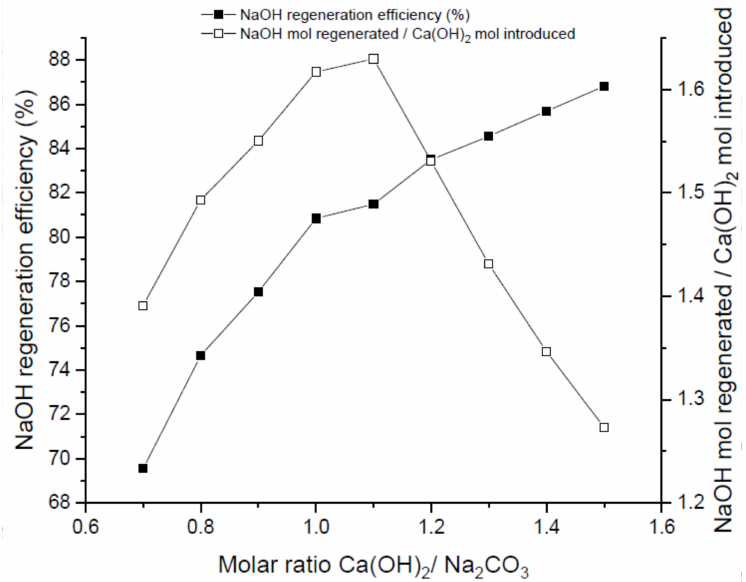
Figure 4. Influence of molar ratio (R) in the regeneration experiments. Runs conducted at t = 30 min and 50 ◦